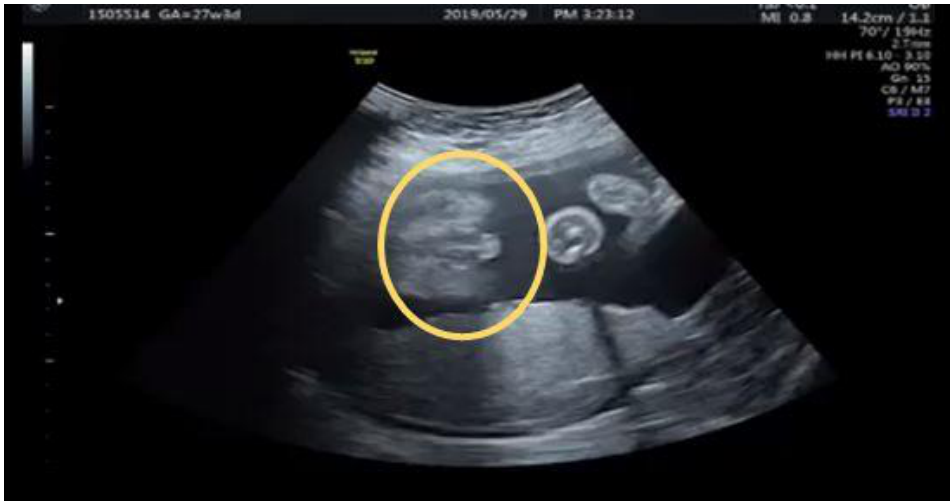
Figure 10. Third degree hypospadias with typical “Tulip” signs (circular).